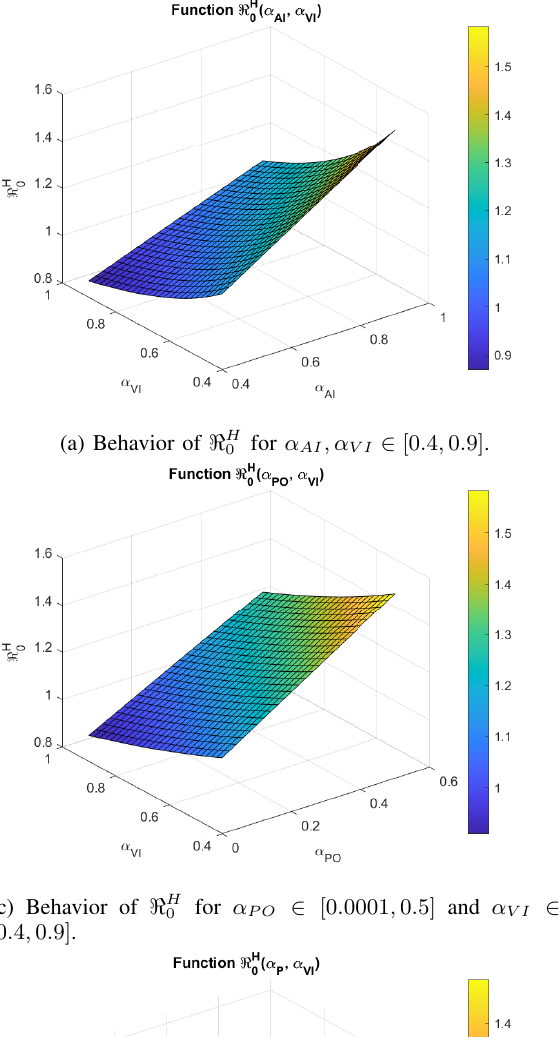
(c) Behavior of (cid:60) H 0 for α PO ∈ [0 . 0001 , 0 . 5] and α V I ∈ [0 . 4 , 0 . 9] .